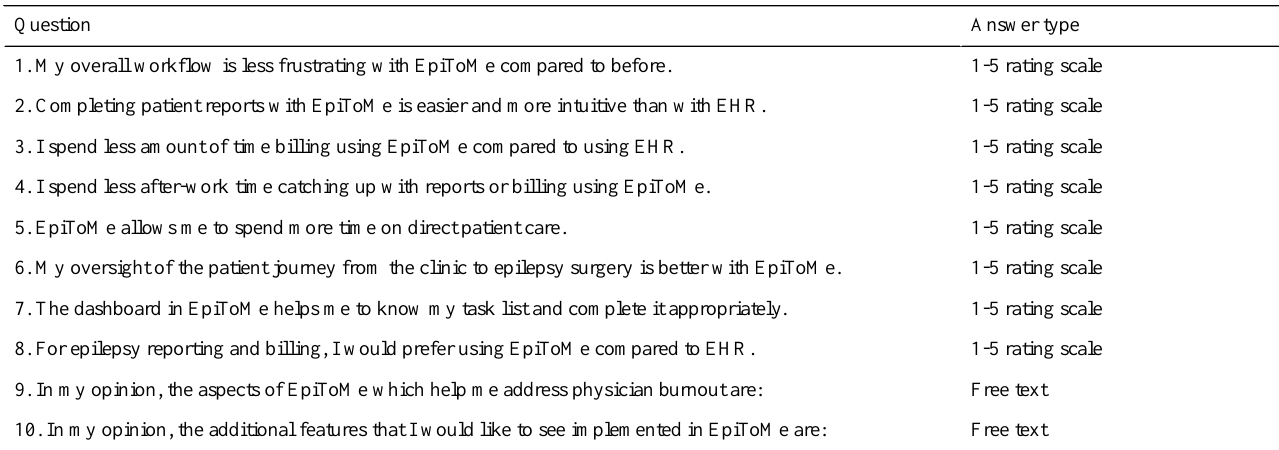
Table 1. The 10 survey questions and their answer options.